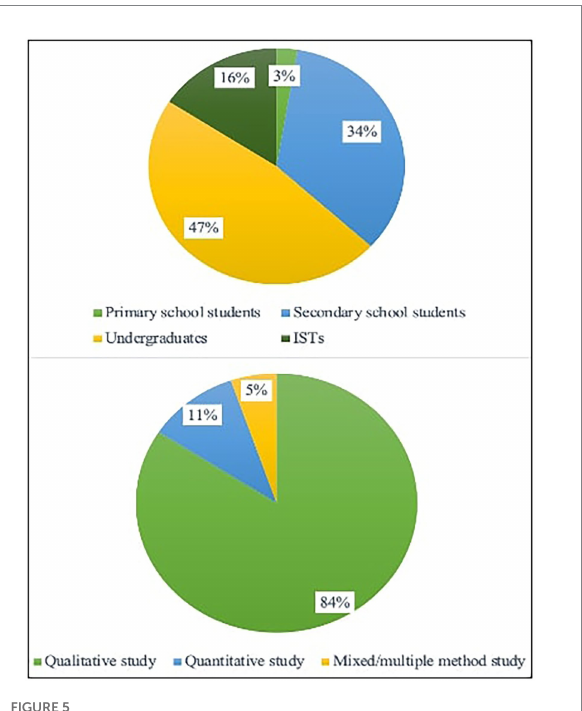
FIGURE 5 Research design and